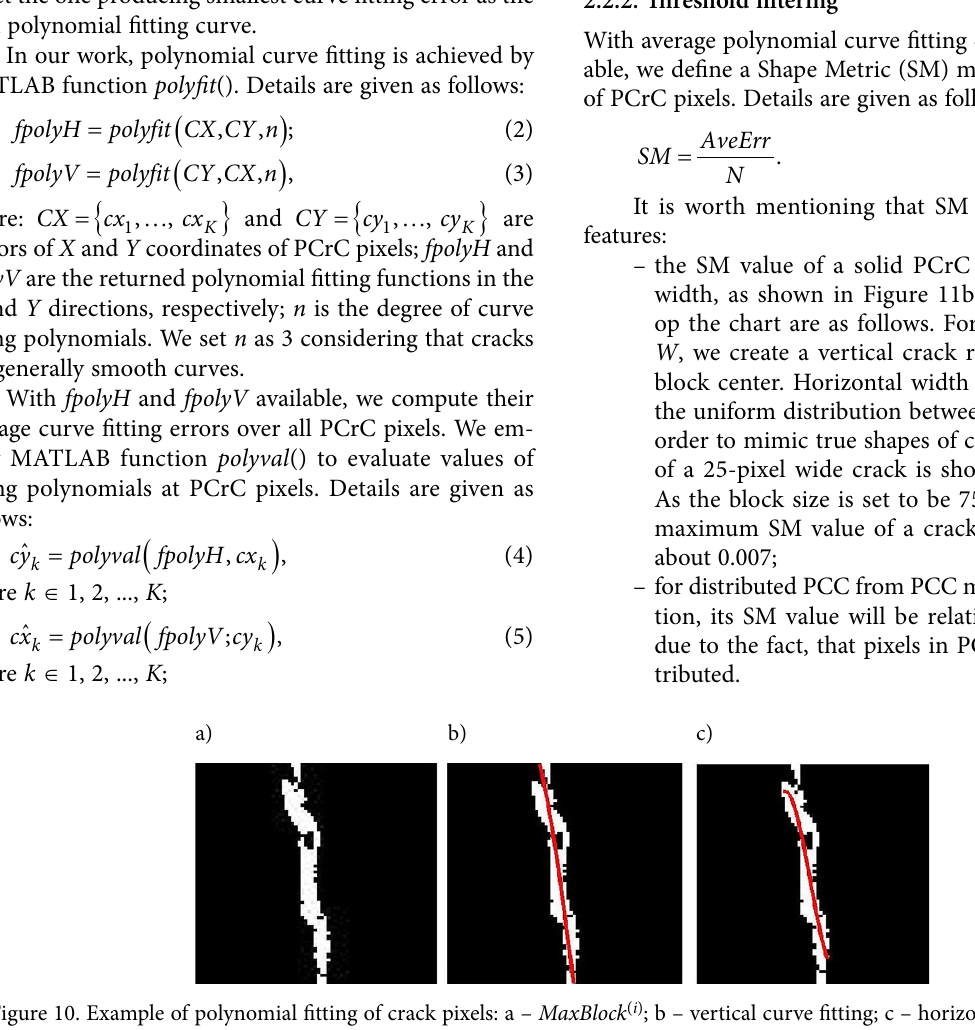
block is set as 3.6303.